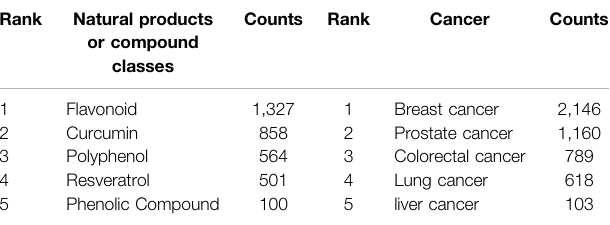
TABLE 9 | The top fi ve productive natural products and cancers related to natural products in cancer research. Rank Natural products or